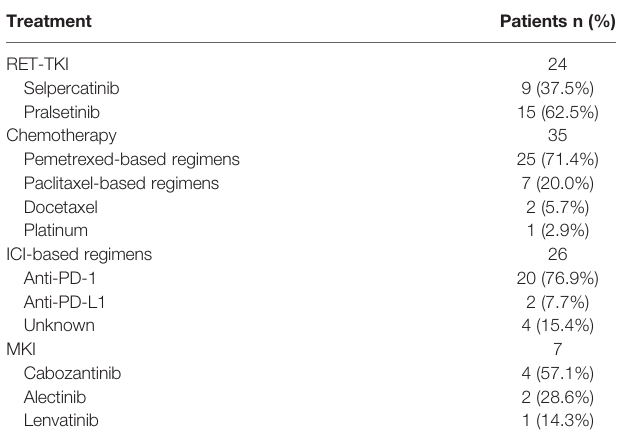
TABLE 2 | Speci fi c treatment regimens of included patients. Treatment Patients n